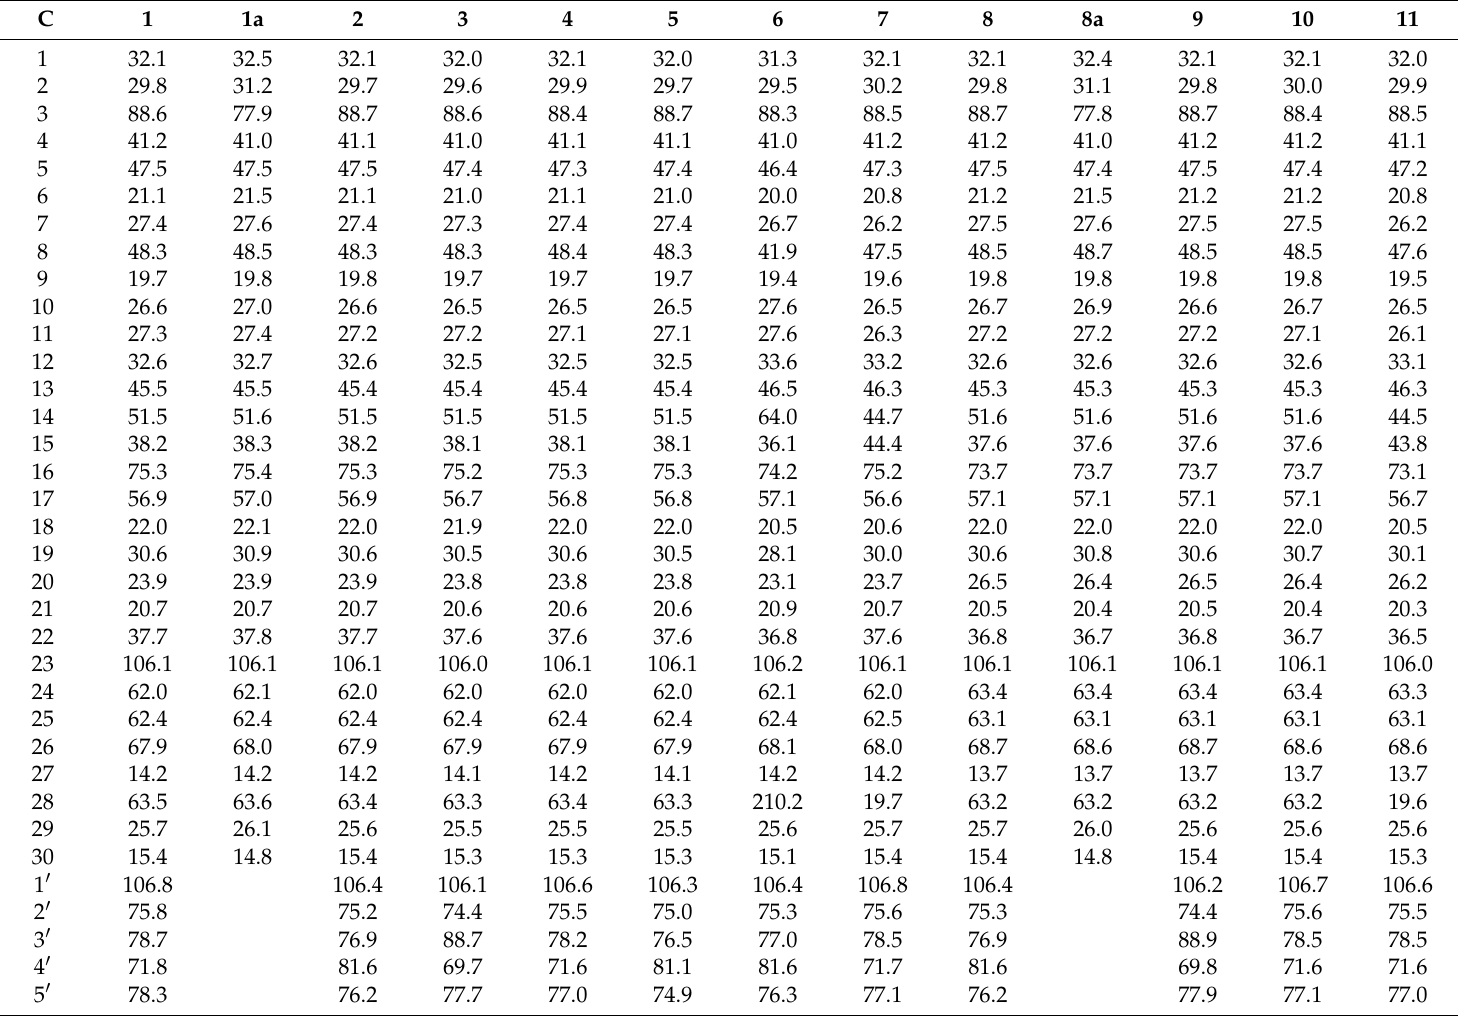
Table 1. 13 C-NMR spectral data for 1 , 1a , 2 – 8 , 8a , and 9 – 11 in C 5 D 5